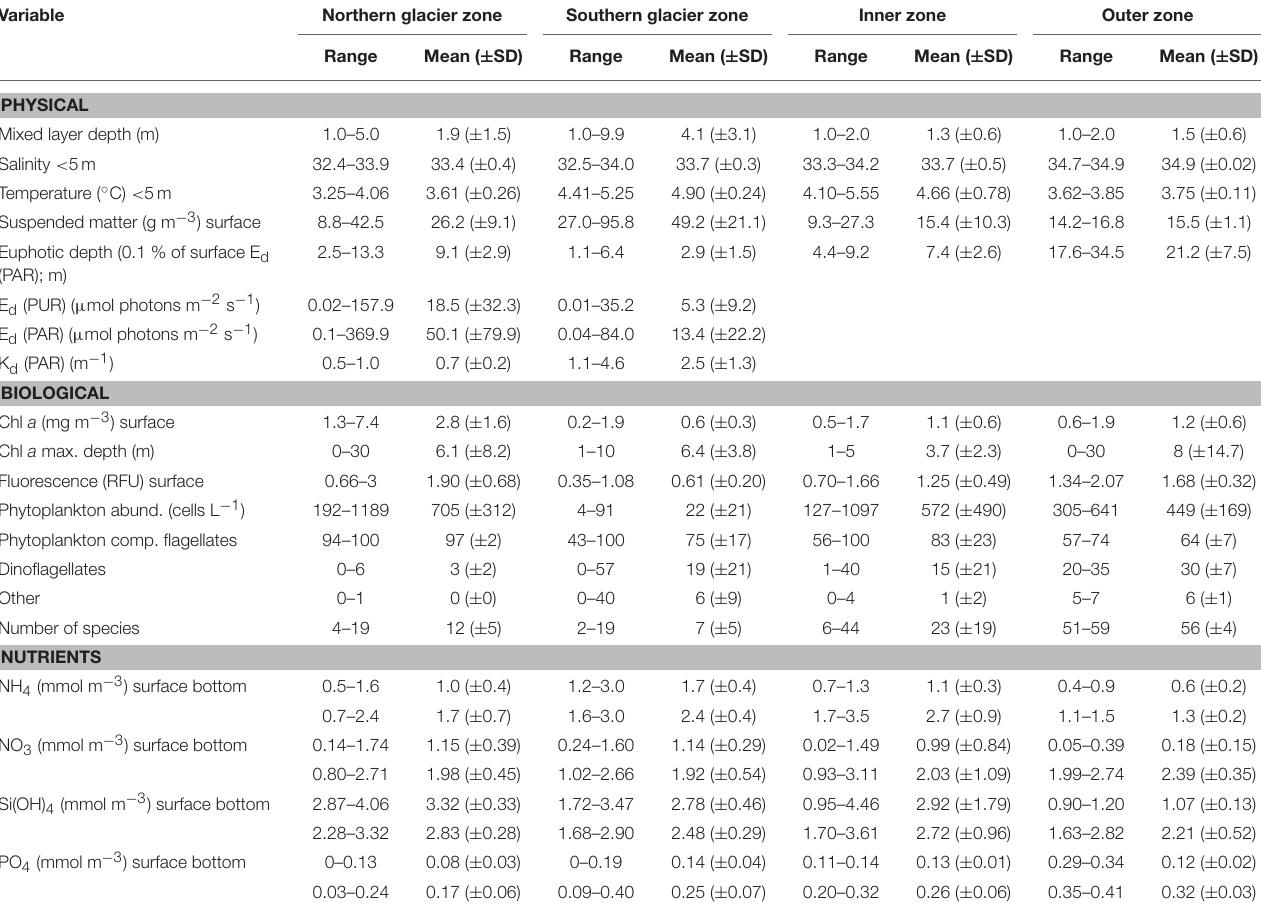
TABLE 1 | Physical and biological variables (range, mean, SD) measured in the four designated zones in Kongsfjorden ( Figure 2